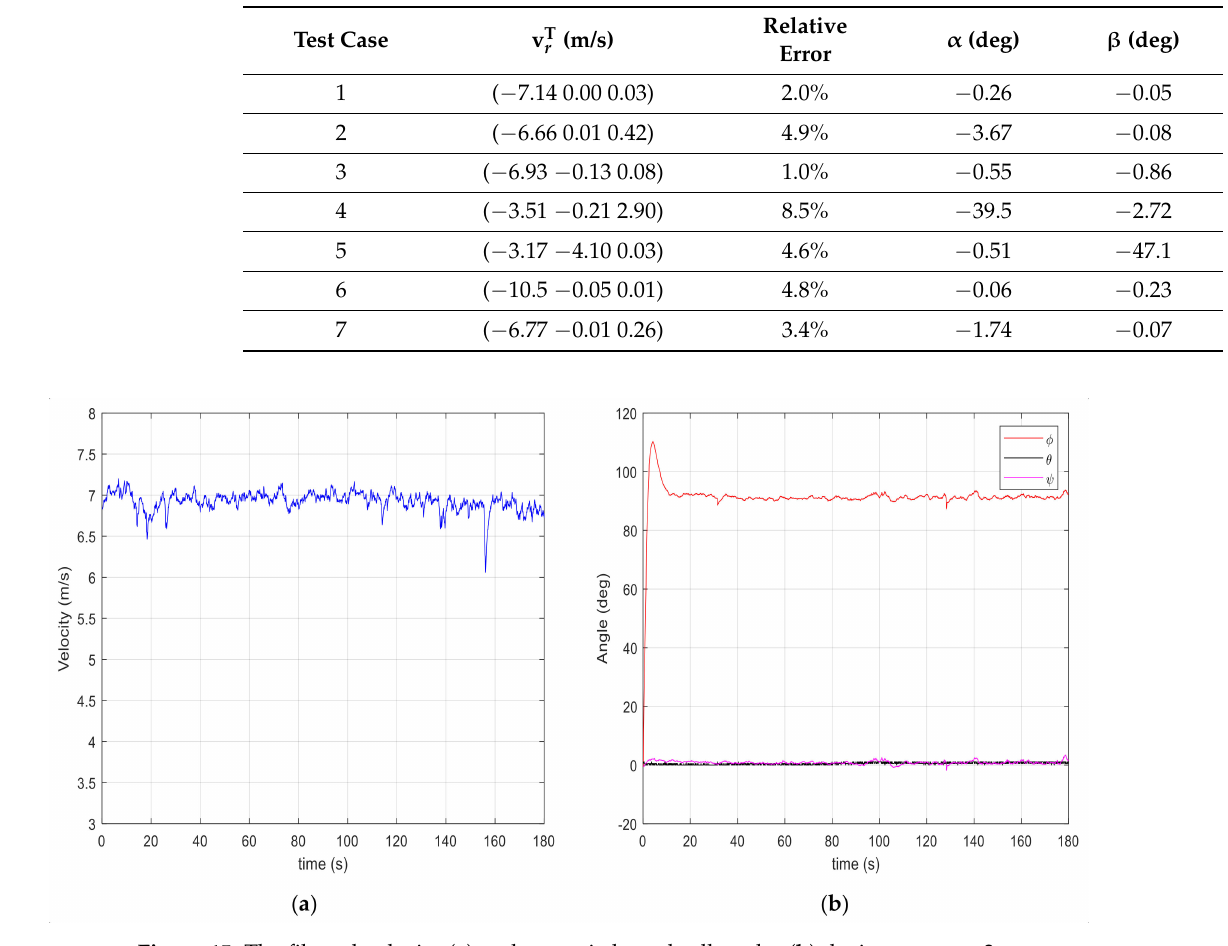
Figure 15. The filtered velocity ( a ) and yaw, pitch, and roll angles ( b ) during test case 3.